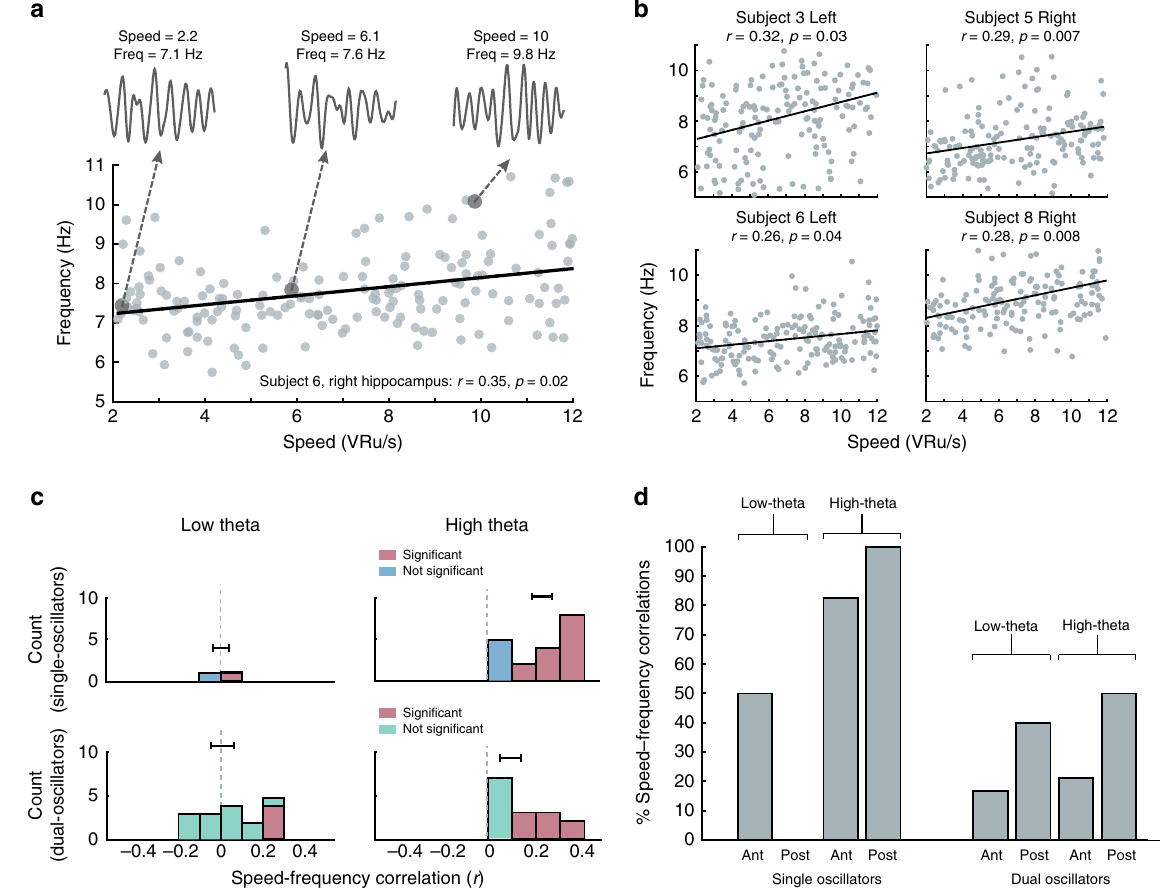
Fig. 5 Analyses of the relation between theta frequency and movement speed. a An example electrode with a positive high-theta frequency – speed correlation. Two-second trace of fi ltered hippocampal oscillations during slow, medium, and fast speeds. Pearson r correlation is reported between speed and frequency, r = 0.35, p = 0.02. b Example electrodes from both left and right hippocampus that display signi fi cantly positive high-theta speed – frequency correlations. Pearson r correlations are reported between speed and frequency for each electrode. c Histogram of correlation coef fi cients for single and dual oscillators, separately aggregated for low- and high-theta bands. Signi fi cant correlations indicated in red. Error bars are SEM. Low-theta single oscillators: n = 2 electrodes. Low-/high-theta dual oscillators: n = 19 electrodes. High-theta single oscillators: n = 19 electrodes. d Percentage of electrodes in each hippocampal region with a signi fi cant positive correlation between movement speed and frequency for both low- and high-theta bands. Data in panels c and d were computed after subsampling to include only one movement epoch per trial. Source data are provided as a Source Data fi